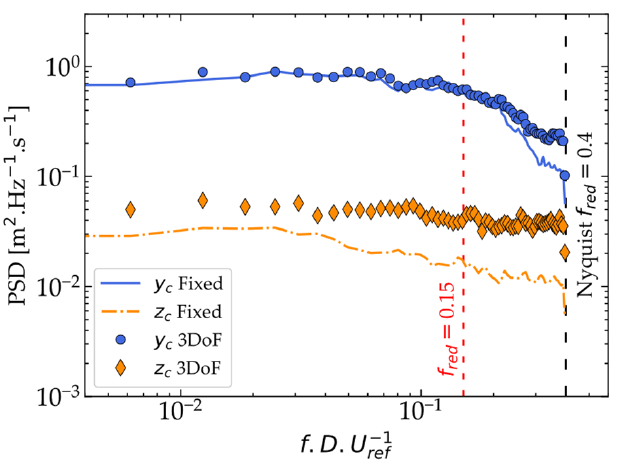
Figure 10. Comparison of the power spectral density (PSD) of lateral and vertical wake centre for the model with two cases of fixed and imposed 3D motion.